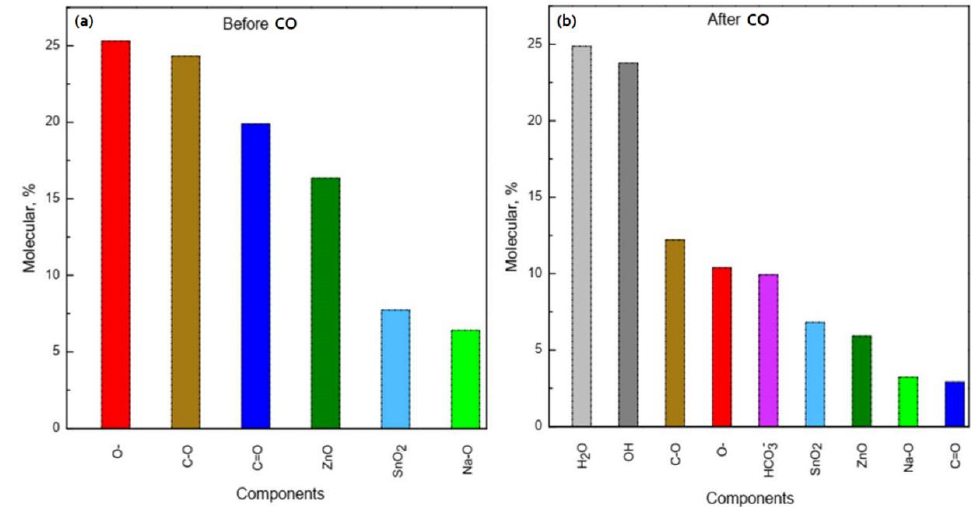
Figure 8. Chemical composition of the ZnO–SnO 2 film surface with the Zn:Sn ratio: 95:5 before ( a ) and after ( b ) CO treatment.